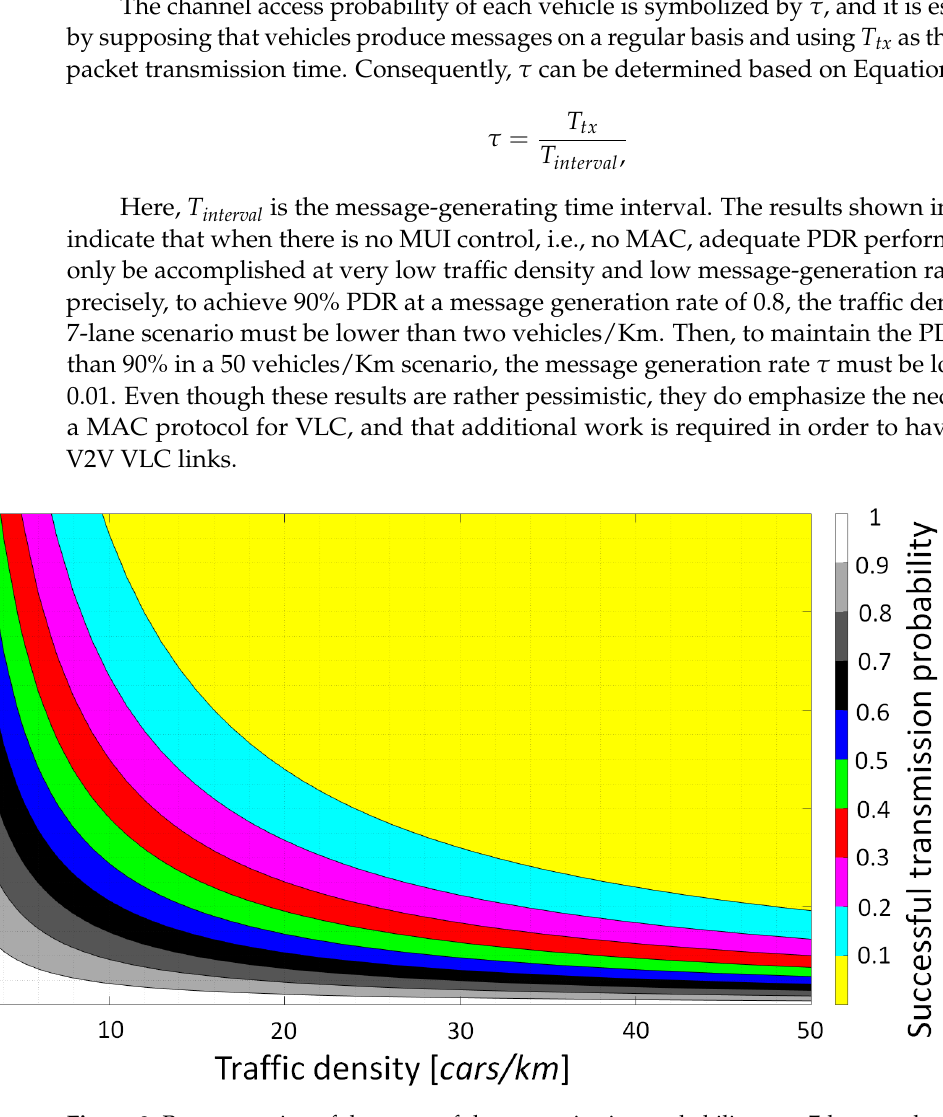
Figure 8. Representation of the successful communication probability on a 7-lane road.